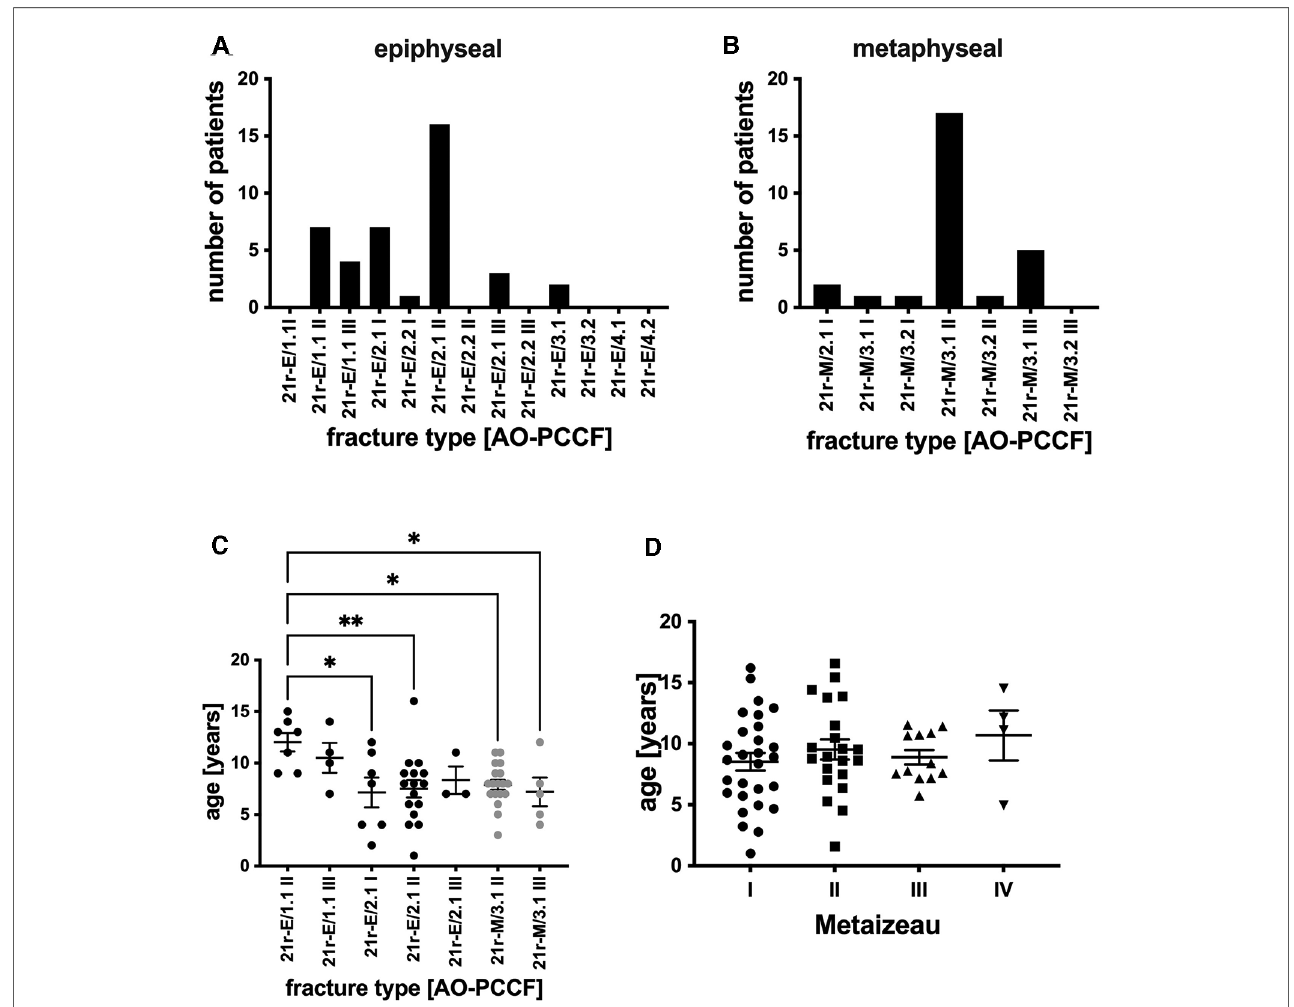
FIGURE 1 ( A ) Number of patients strati fi ed by AO classi fi cation [AO-PCCF] with radial head/epiphyseal radial fractures. ( B ) Number of patients strati fi ed by AO classi fi cation [AO-PCCF] with radial neck/metaphyseal radial fractures. The radial head fracture types 21r-E/1.1 I, 21r-E/2.2 II, 21r-E/2.2 III, 21r-E/3.2, 21r-E/ 4.1, and 21r-E/4.2 were not present as well as the radial neck fracture type 21r-M/3.2 III is therefore not depicted in panels A and B. ( C ) Age in years of patients in respective AO-PCCF fracture types. AO-PCCF fracture types for which two or fewer patients were included are not shown in this panel. ( D ) Age in years in respective Metaizeau types (I – IV). * p <0.01, ** p <0.001, graphical presentation as